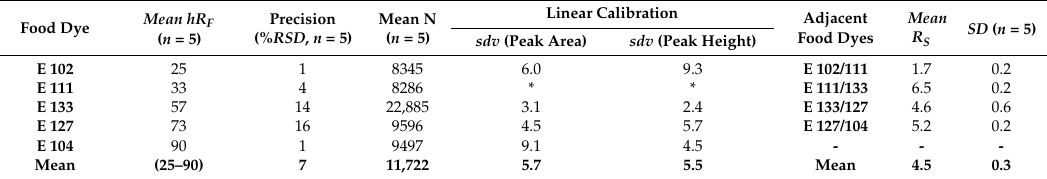
Table 1. Performance data of electrospun PAN nanofiber phases: Mean hR F values of five water-soluble food dyes and their precisions for five different separations as well as the mean plate numbers N , linear 4-point calibrations and mean resolutions R S , calculated between adjacent water-soluble food